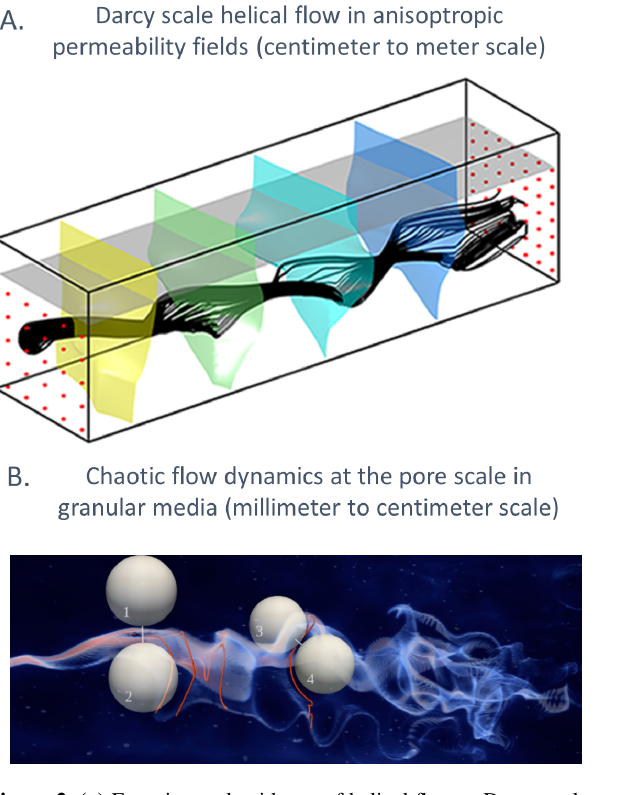
Figure 2. (a) Experimental evidence of helical flow at Darcy scale (top, modified from Ye et al., 2015): the black lines show simulated streamlines, the colored surfaces iso-pressure surfaces, and the red dots are experimental sampling points. (b) Experimental evidence of chaotic mixing at the pore scale in 3D porous media (bottom, modified from Heyman et al., 2020): the color field shows the con- centration of a continuously injected fluorescent dye, the red line is the intersection of the plume with a 2D plane transverse to the mean flow, which shows the stretching and folding patterns that produce chaotic mixing, and the gray spheres represent selected grains in the bead pack that create the first successive folding of the